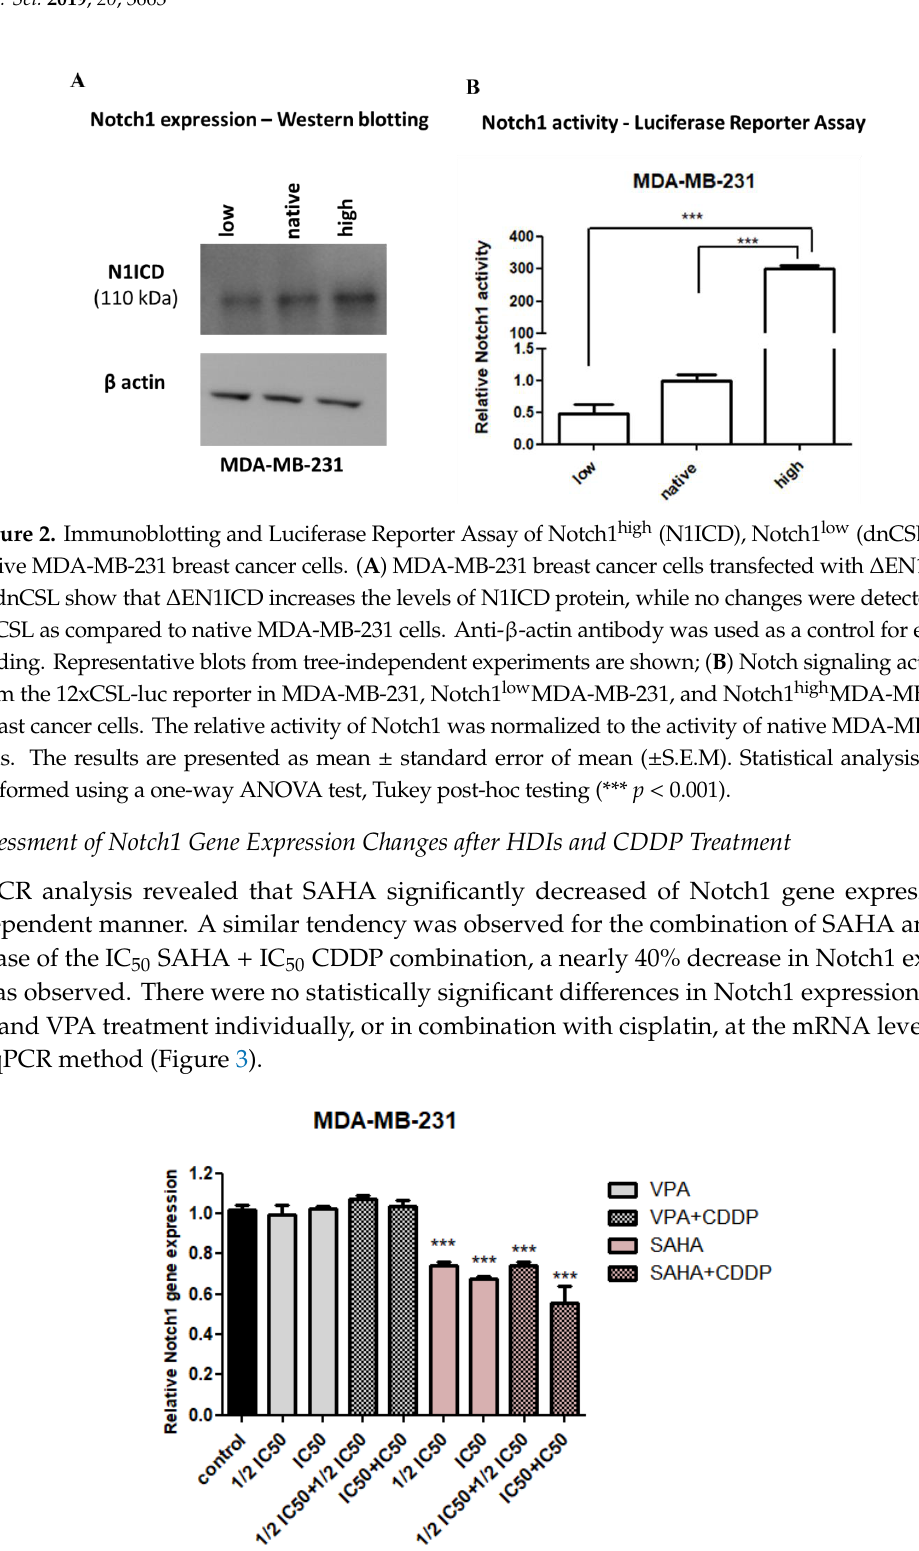
IC 50 ; IC 50 ), or SAHA ( 1 IC 50 2 2